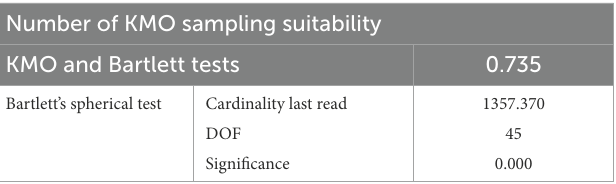
TABLE 8 Table of empirical scales Bartlett sphericity test and KMO test.